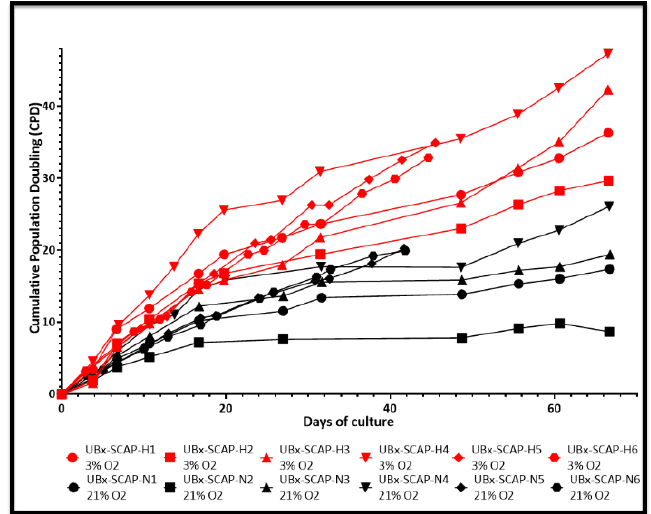
Figure 2. Proliferative advantage of SCAPs banks derived at 3% O 2 in comparison with 21% O 2 . Curves passing by all points represent the cumulative population doubling of SCAPs grown for the indicated number of days.